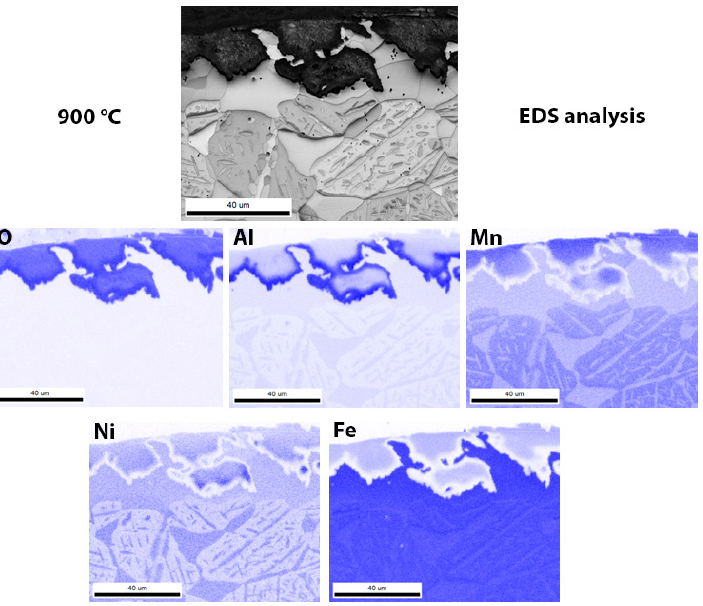
Figure 9. EDS analysis of the surface distribution of the elements in the oxide layer formed after high-temperature oxidation at 900 °C.